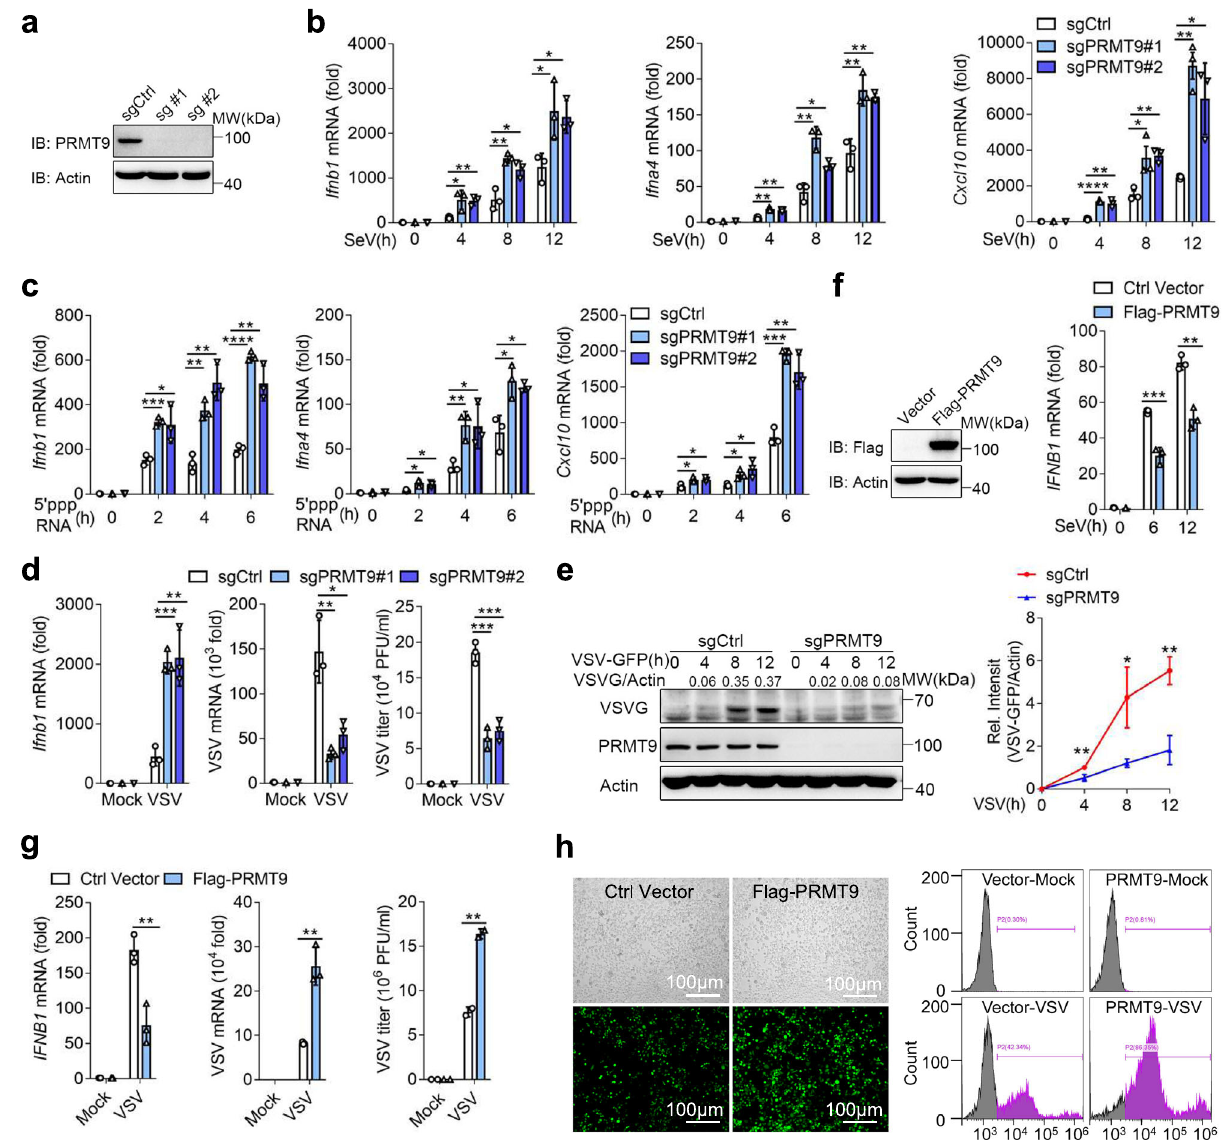
Fig. 1 | PRMT9 negatively regulates RLRs-induced IFN- β production. a Immunoblot analysisof PRMT9in Prmt9 -knockout RAW264.7 cell lines. b , c